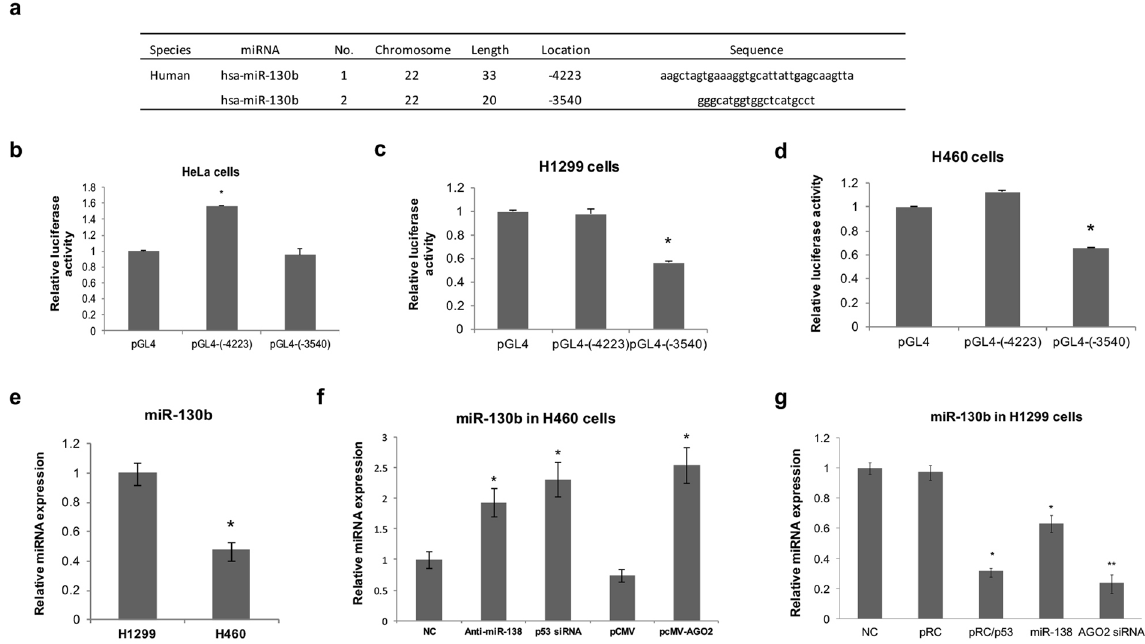
Figure 3. The regulatory effect of p53 on miR-130b. ( a ) Sequences and positions of the predicted p53-binding sites in the promoter of the miR-130b gene. The predicted p53-binding sites were incorporated separately into the basic promoter of a firefly luciferase reporter gene (named pGL4-(-4223) and pGL4-(-3540)). ( b – d ) pRC/p53 plasmids were co-transfected with the luciferase reporter plasmid pGL4-(-4223), pGL4-(-3540), or empty pGL4 vector into HeLa ( b ), H1299 ( c ) and H460 ( d ) cells. After 48 h, the luciferase activity was measured. * P < 0.05 vs . the control by one-way ANOVA test. ( e ) Quantitative RT-PCR assays were performed to examine the relative miR-130b expression levels in H1299 and H460 cells. * P < 0.05 by rank-sum test. ( f ) Quantitative RT-PCR assays were performed to examine the relative miR-130b expression levels in H460 cells transfected with anti-miR-138, p53 siRNA, or pCMV-AGO2. * P < 0.05 vs . NC by one-way ANOVA test. ( g ) Quantitative RT-PCR assays were performed to examine the relative miR-130b expression levels in H1299 cells transfected with pRC/p53, miR-138, or AGO2 siRNA. The qRT–PCR expression values were normalized to that of U6. * P < 0.05 and ** P < 0.01 vs . the control by one-way ANOVA test. The data are representative of three independent experiments (mean ±